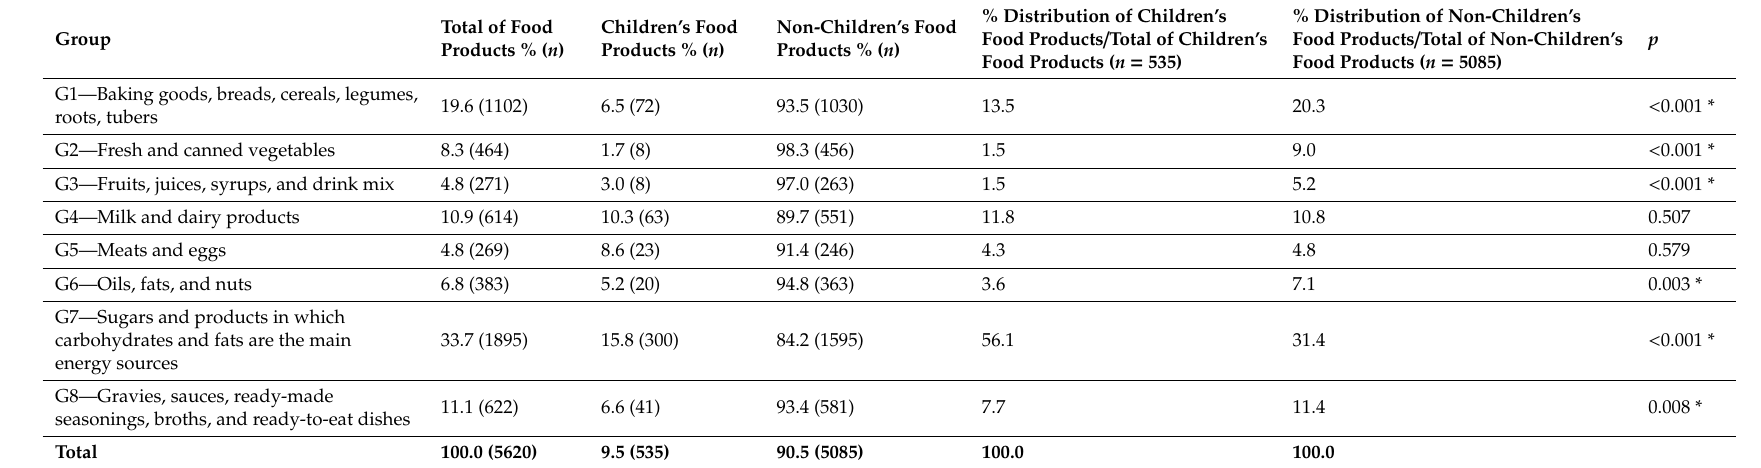
Table 1. Distribution of packaged food products available in a large Brazilian supermarket store and proportion of children’s food products into the food groups established by the Brazilian / Mercosur Regulation ( n =